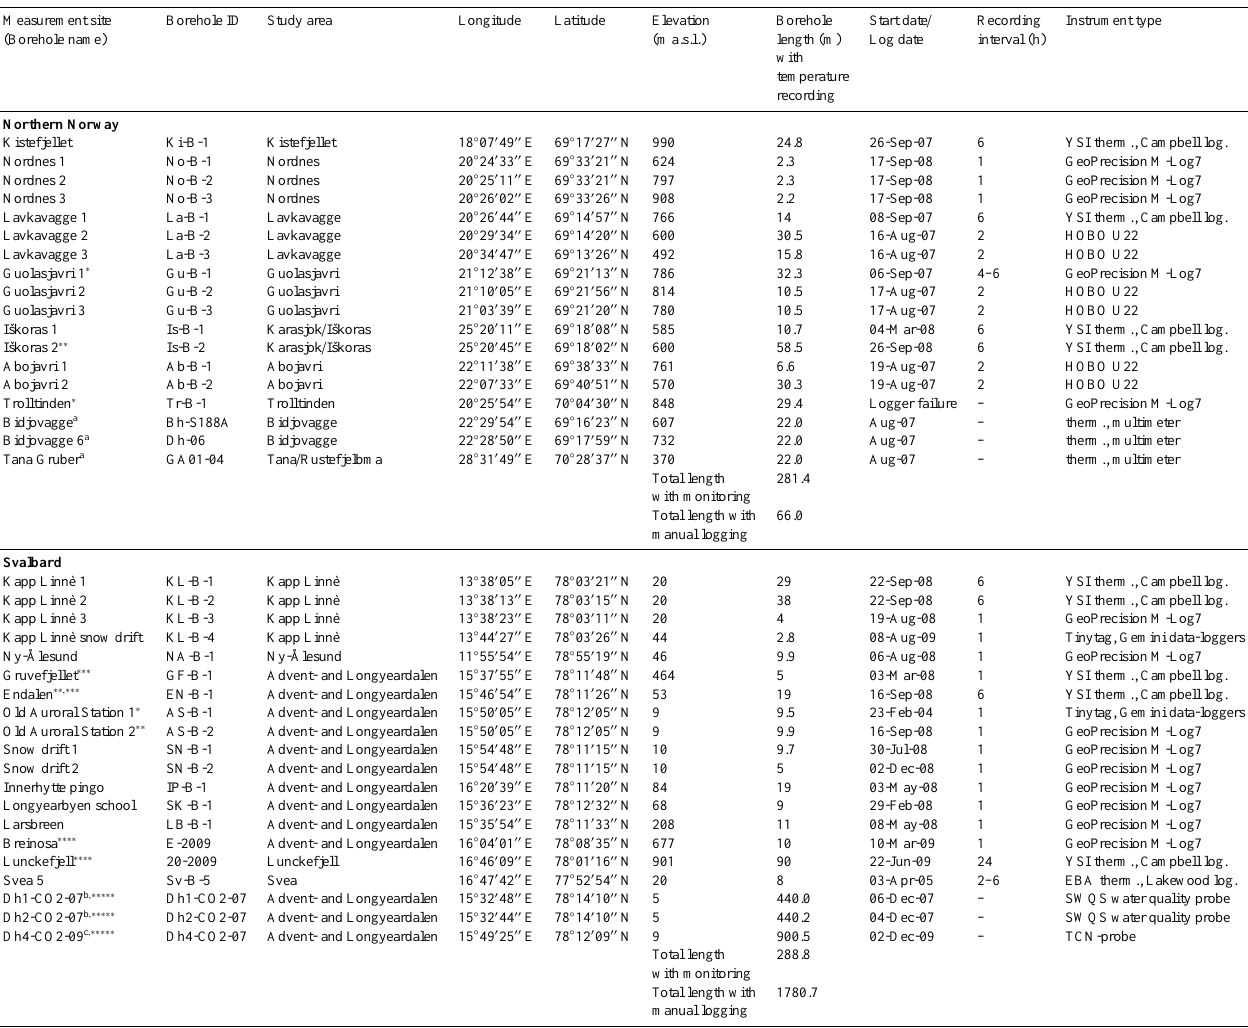
Table 2. All NORPERM TSP NORWAY borehole measurement sites, with location, borehole length with temperature data, the start date of monitoring or alternatively the data for manual logging, recording interval in the case of monitoring and type of instrument used. The accuracy of the di ff erent instrument types are as follows: YSI-thermistors connected to a Campbell data-logger ± 0.05 ◦ C, GeoPrecision M-Log7 ± 0.2 ◦ C, HOBO U22 ± 0.2 ◦ C, Tinytag ± 0.2 ◦ C, EBA thermistor-string connected to Lakewood data-logger ± 0.2 ◦ C. The TCN- and SWQS-probes have accuracies of ± 0.5 and ± 0.02 ◦ C, respectively. The accuracy of the manual readings with multimeter is assumed to be ± 0.1 ◦